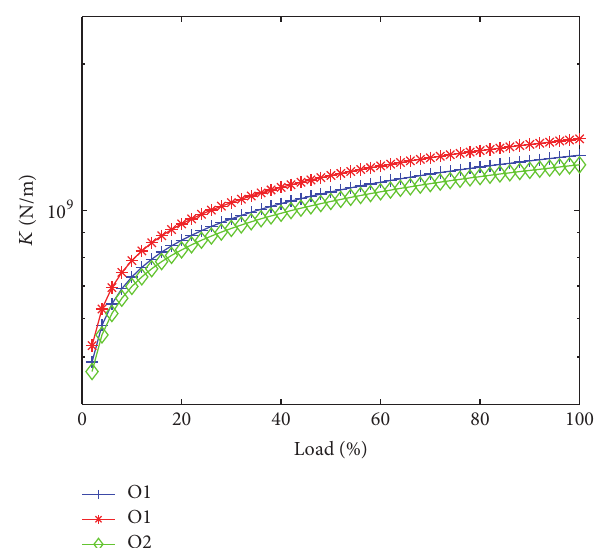
Figure 13: Effect of increasing workload on the gear meshing stiffness of three output